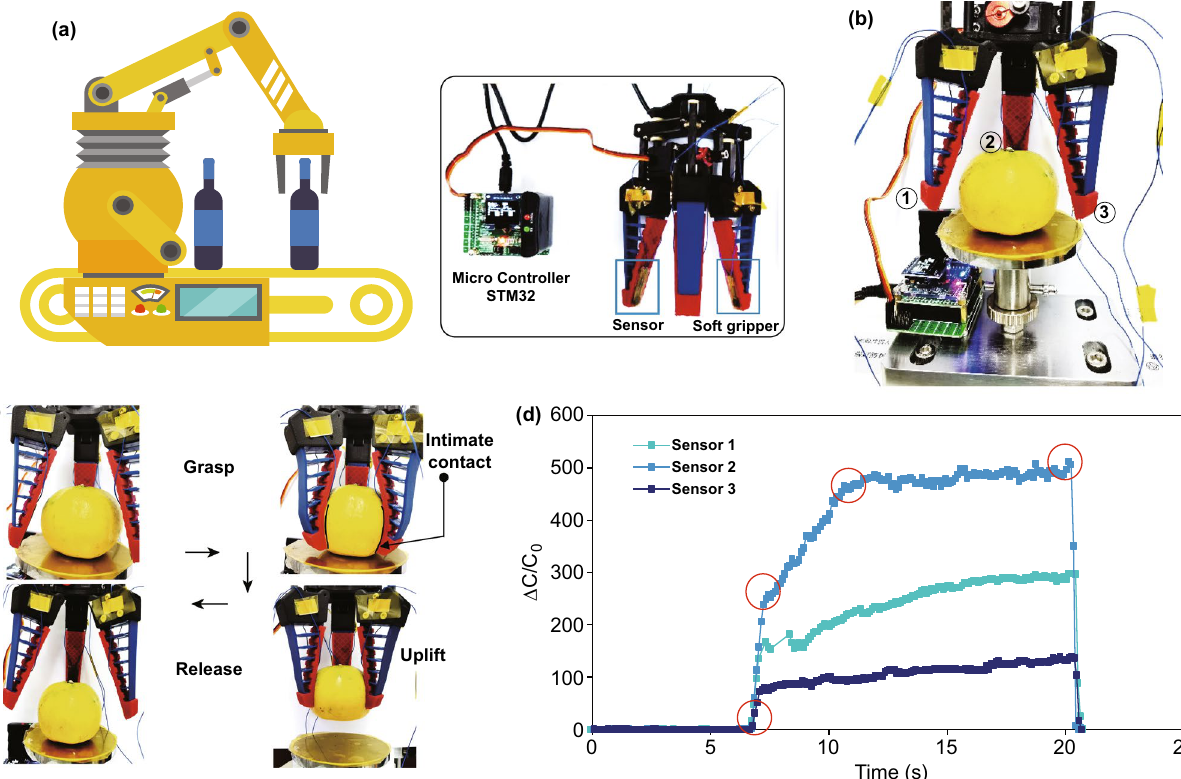
Fig. 6 Practical application of the flexible iontronic sensor for electronic skin. a , b Configuration of the wirelessly controlled soft gripper with flexible sensor to achieve product grasping. c Procedures for the soft gripper to capture and release the orange. d Capacitance variations of the sensor during the process to grasp and release the